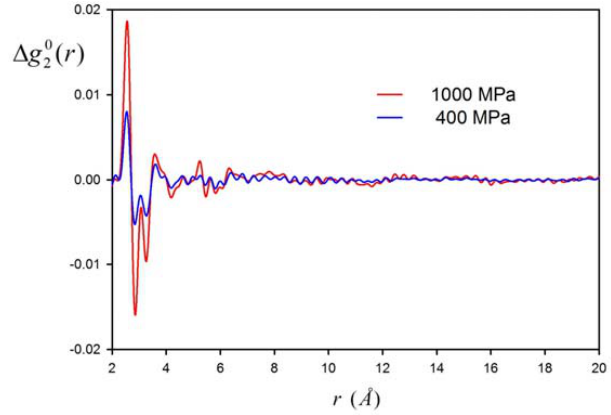
Figure 8. The difference PDF, ∆ g 20 ( r ) = g 20 (affine) − g 20 (data), for the applied stress of 400 and 1000 MPa.